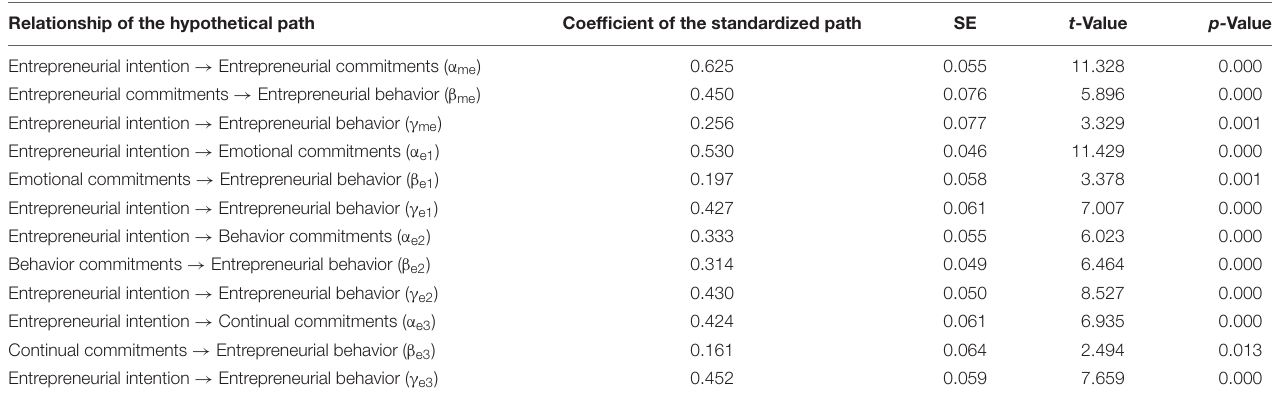
TABLE 4 | The result of the path analysis. Relationship of the hypothetical